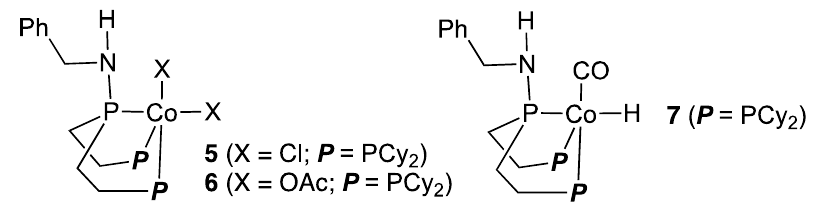
Figure 2. Depiction of complexes 5 – 7 .